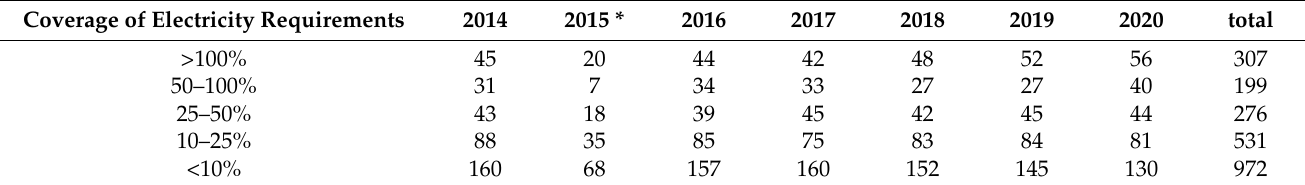
Figure 4. Biogas production potential from biodegradable waste according to the number of operators. Table 1. Number of food business operators able to cover the energy consumption based on biogas from their own waste. Source: Own study.